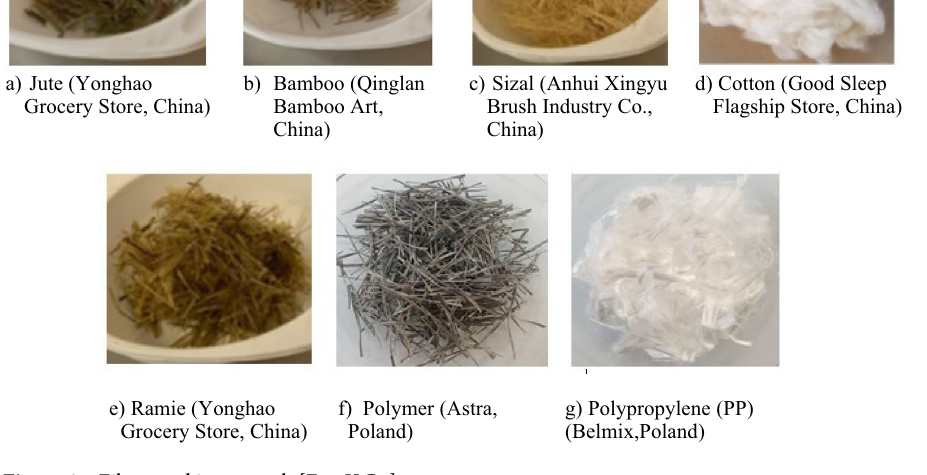
Figure 2. Fibre used in research [Fot.